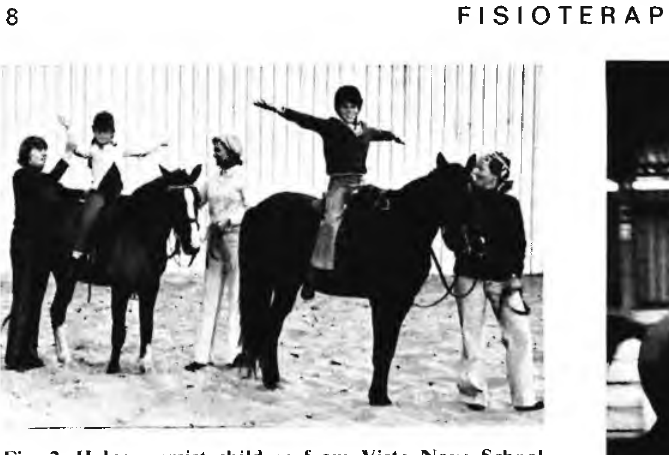
Fig. 2. Helpers assist children from Vista Nova School with the preliminary exercises. After more exercises along these lines lessons pro­ ceed normallv. with the children learning lo control their ponies at a walk and trot. Most pupils start with three helpers — one leading the pony and one on either side of the rider but. as a physiotherapist in England commented, "One should judge the success of the group not by the number of helpers one uses, but b\ the number one can do without!" Very few of out pupils now require more than one helper and many can ride their ponies